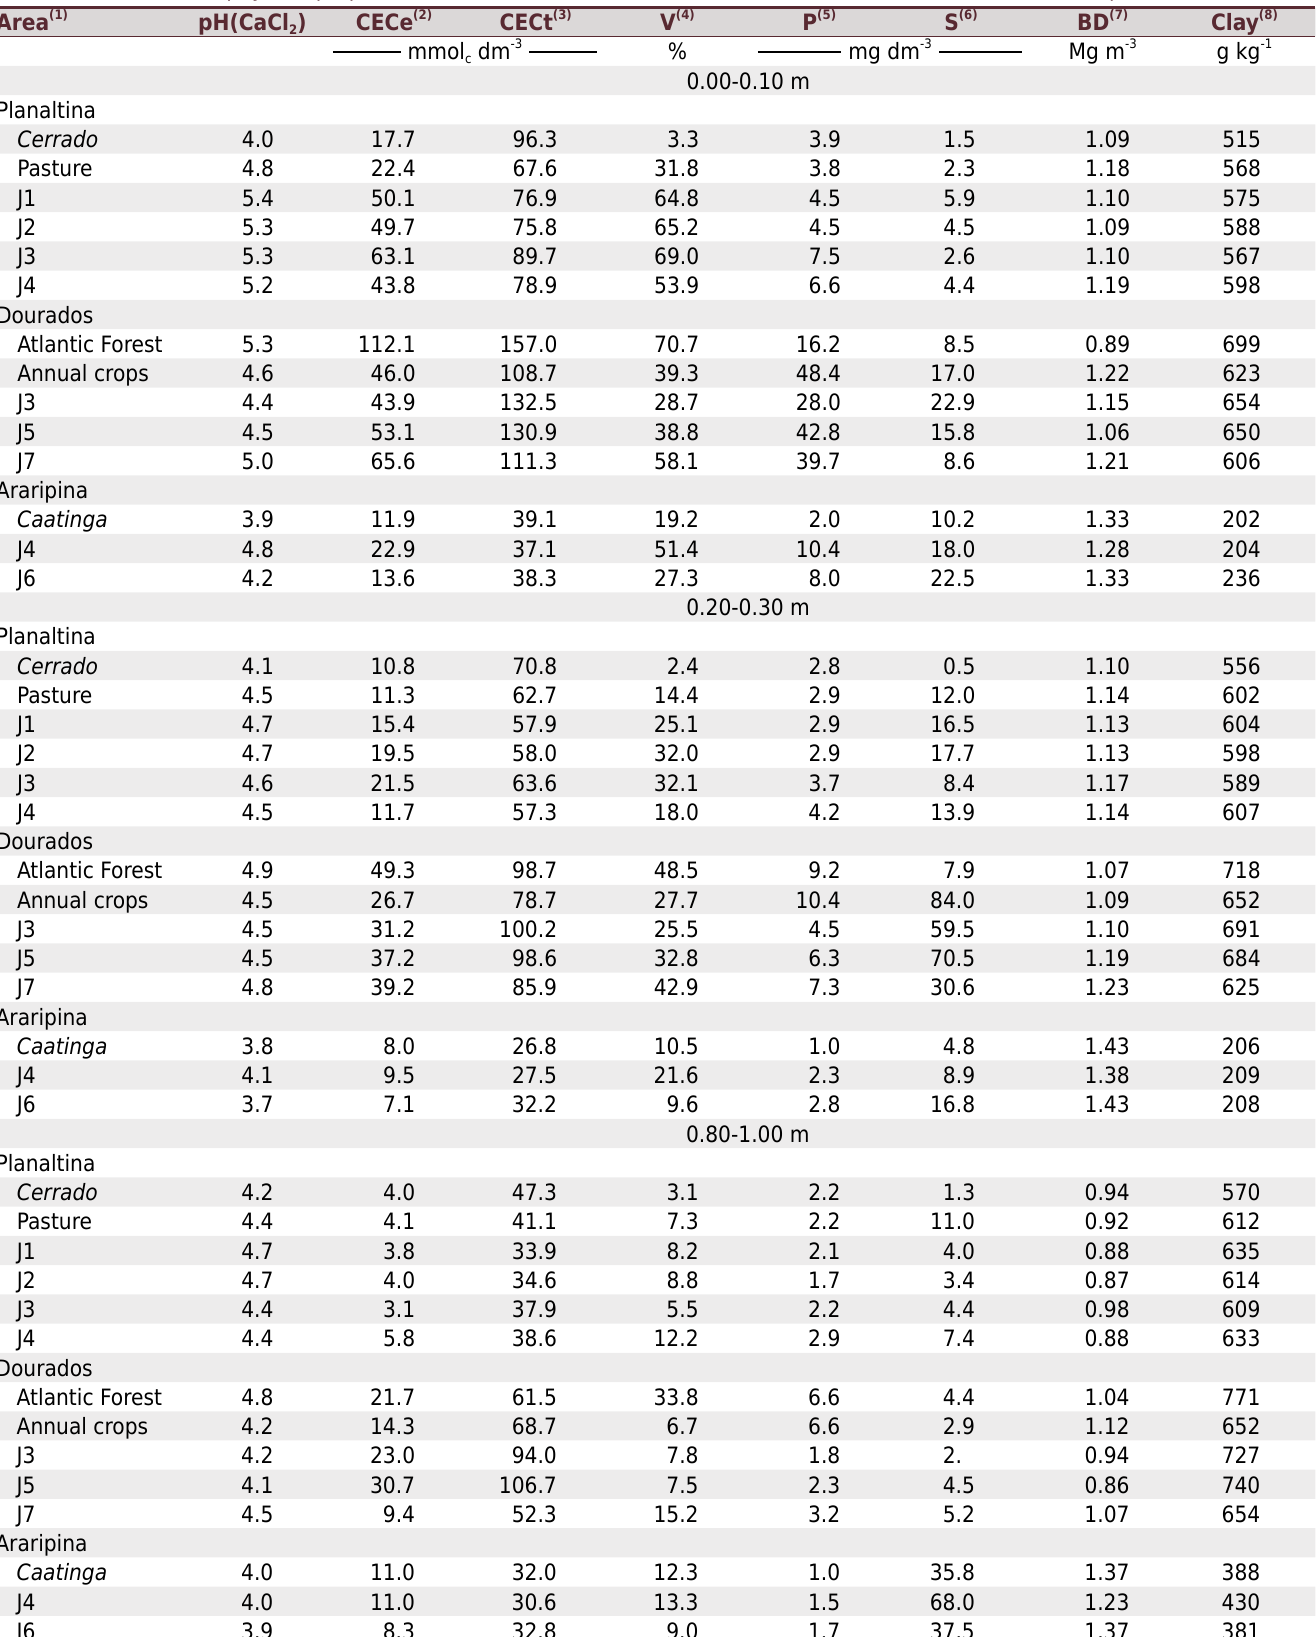
Table 1. Chemical and physical properties in soils with different uses in Planaltina-DF, Dourados-MS, and Araripina-PE, Brazil Area